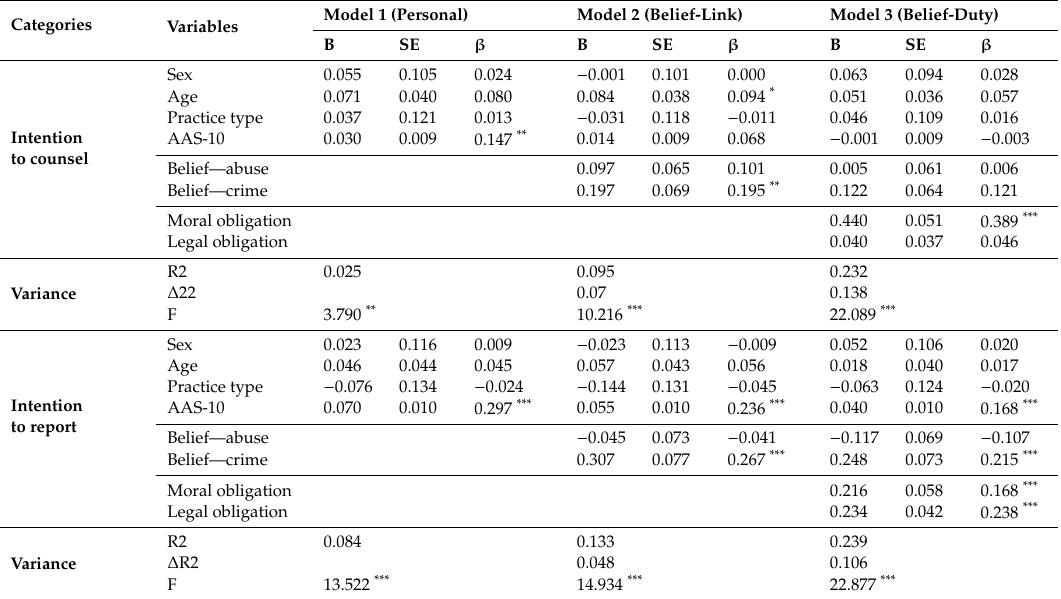
Table 6. Hierarchical regression analysis predicting the veterinary practitioners’ intention to intervene in animal abuse